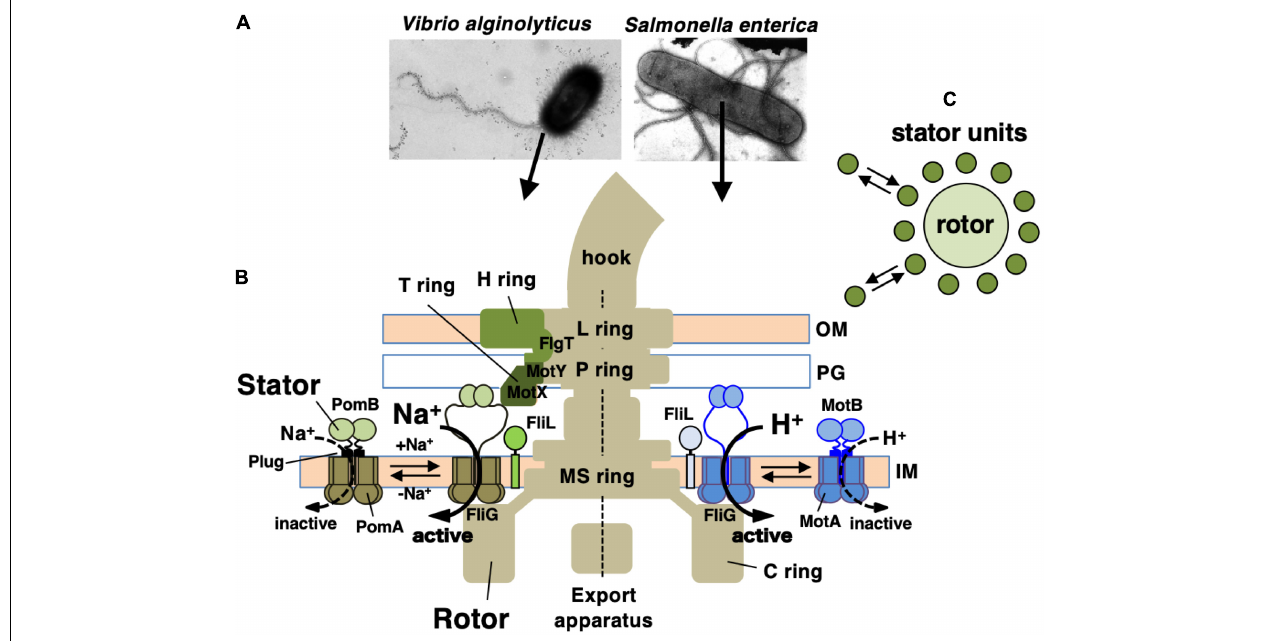
FIGURE 1 | (A) Negatively stained bacteria were observed by electron microscopy in Vibrio alginolyticus (left side) and Salmonella enterica (right side). (B) Schematic drawing of the flagellum, which is a motility organelle that has a motor associated with the cell membrane. On the left is the sodium-driven polar flagellar motor of V. alginolyticus , and to the right shown the proton-driven flagellar motor of S. enterica . The Vibrio motor contains additional ring structures, the T ring and H ring, in addition to the L ring and P ring. The stator complex is composed of two integral membrane proteins, PomA and PomB, for the sodium-driven motor and MotA and MotB for the proton-driven motor. The stator is anchored to the PG layer around the rotor via the periplasmic domain of the B subunit. OM, outer membrane; IM, inner membrane; PG, peptidoglycan layer. FliL is located at the flagellar base close to the stator. (C) Schematic drawing of the dynamic assembly and disassembly of the stator units in the flagellar motor.